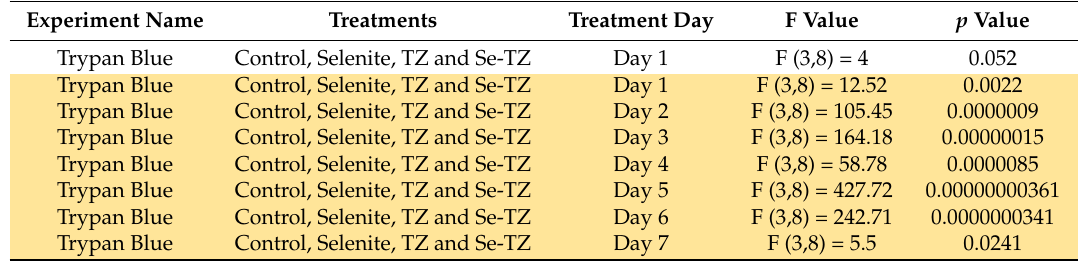
Table 2. ANOVA Results for Cell Viability with Se-TZ Treatment for MDA-MB-468 Cells.